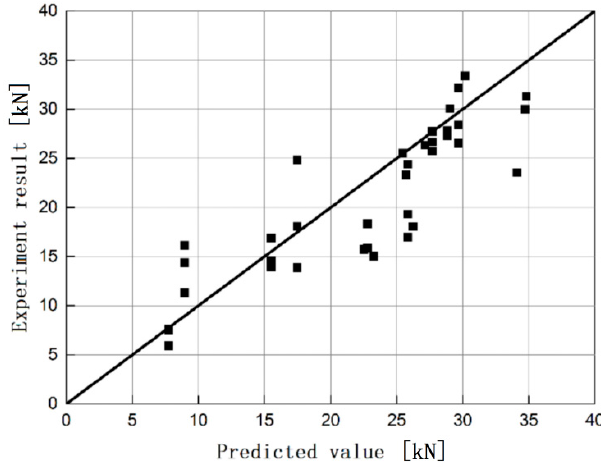
Figure 9. Comparison of the predicated interfacial ultimate bearing capacity and the experimental results.